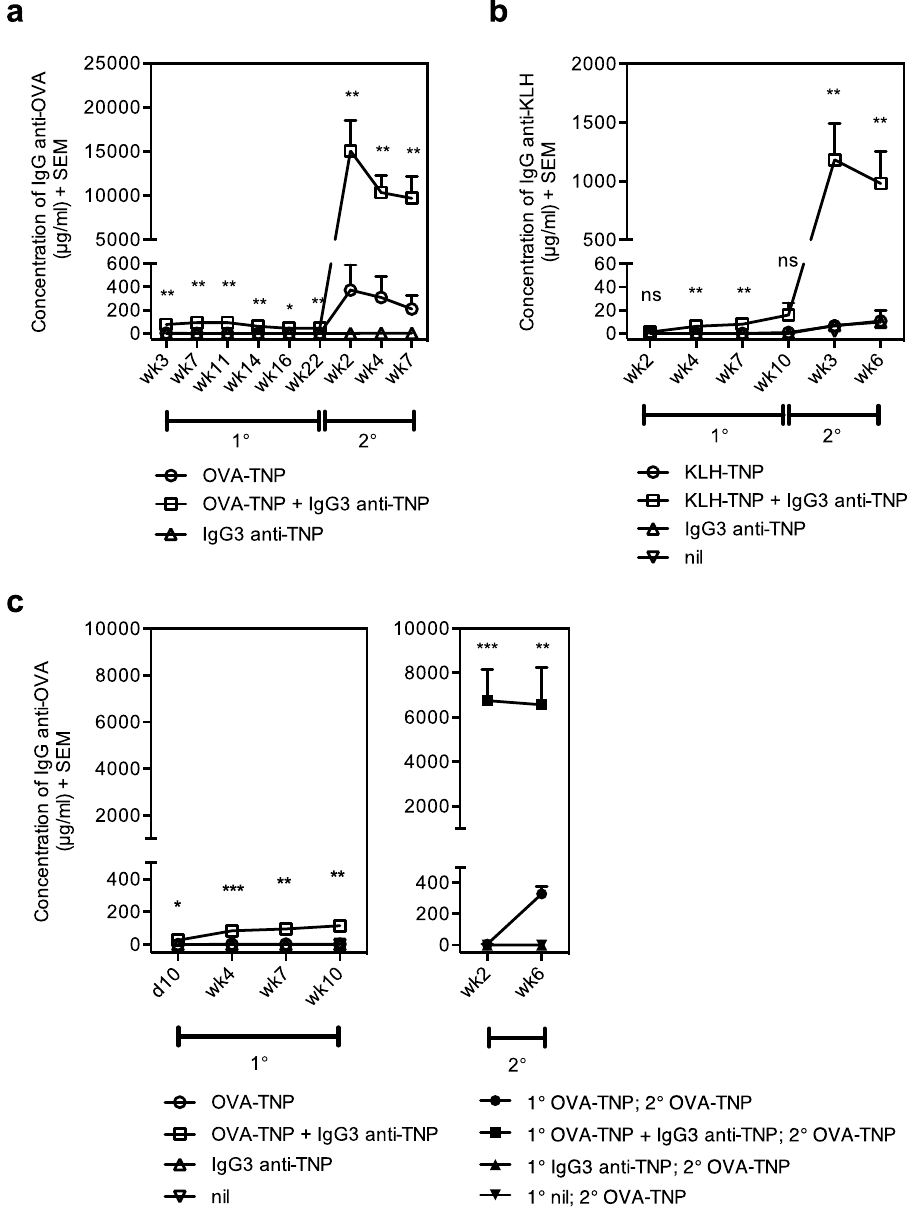
Figure 5. IgG3 enhances induction of immunological memory. ( a ) BALB/c mice were primed i.v . with 50 μ g IgG3 anti-TNP (IM-F10) alone (n = 3), 20 μ g OVA-TNP (n = 6), or a mixture of 50 μ g IgG3 anti-TNP (IM-F10) and 20 μ g OVA-TNP (n = 6). Twenty-two weeks after priming, all mice were boosted i.v . with 20 μ g OVA-TNP. ( b ) BALB/c mice were primed i.v . with 50 μ g IgG3 anti-TNP (IM-F10) alone (n = 3), 10 μ g KLH-TNP (n = 6), a mixture of 50 μ g IgG3 anti-TNP (IM-F10) and 10 μ g KLH-TNP (n = 6), or left untreated (nil, n = 1). Ten weeks after priming, all mice were boosted i.v . with 10 μ g KLH-TNP. ( c ) BALB/c mice were primed i.v . with 50 μ g IgG3 anti-TNP (IM-F10) alone (n = 2), 20 μ g OVA-TNP (n = 3), or a mixture of 50 μ g IgG3 anti-TNP (IM-F10) and 20 μ g OVA-TNP (n = 3), or left unimmunized (nil, n = 1). Ten weeks after priming, single cell suspensions of the spleens from each group were prepared and 15 × 10 6 cells/mouse were transferred to naïve BALB/c mice that had been whole-body irradiated the day before. All recipients were “boosted” i.v . with 20 μ g OVA-TNP immediately after transfer. ( a–c ) Mice were bled at the indicated time points. Sera were diluted 1:25 (in all antigen alone and IgG3 alone groups), 1:625 (in IgG3 + antigen-group in the primary-response phase) or 1:78125 (in IgG3 + antigen-group in the secondary-response phase) and screened in ELISA. ( a ) is representative of three experiments (two in BALB/c and one in C57BL/6 mice). ( b ) and ( c ) are representative of two experiments each in BALB/c mice. The p values for comparisons of the responses in mice immunized with antigen alone or IgG3-antigen complexes are indicated. ns, p > 0.05; * p < 0.05; ** p < 0.01; *** p <